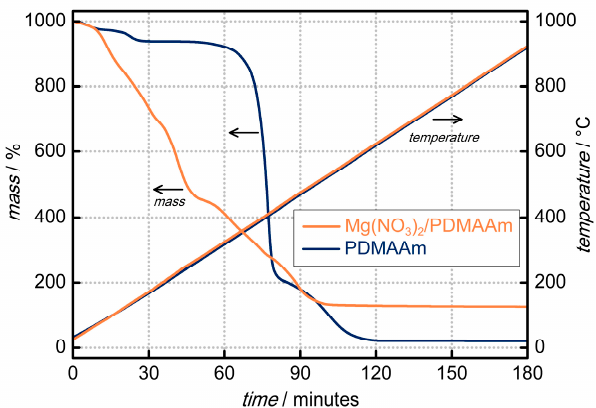
Figure 5. Thermo-gravimetric analysis (TGA) of the Mg(NO 3 ) 2 -polymer composite and of the pure PDMAAm polymer.